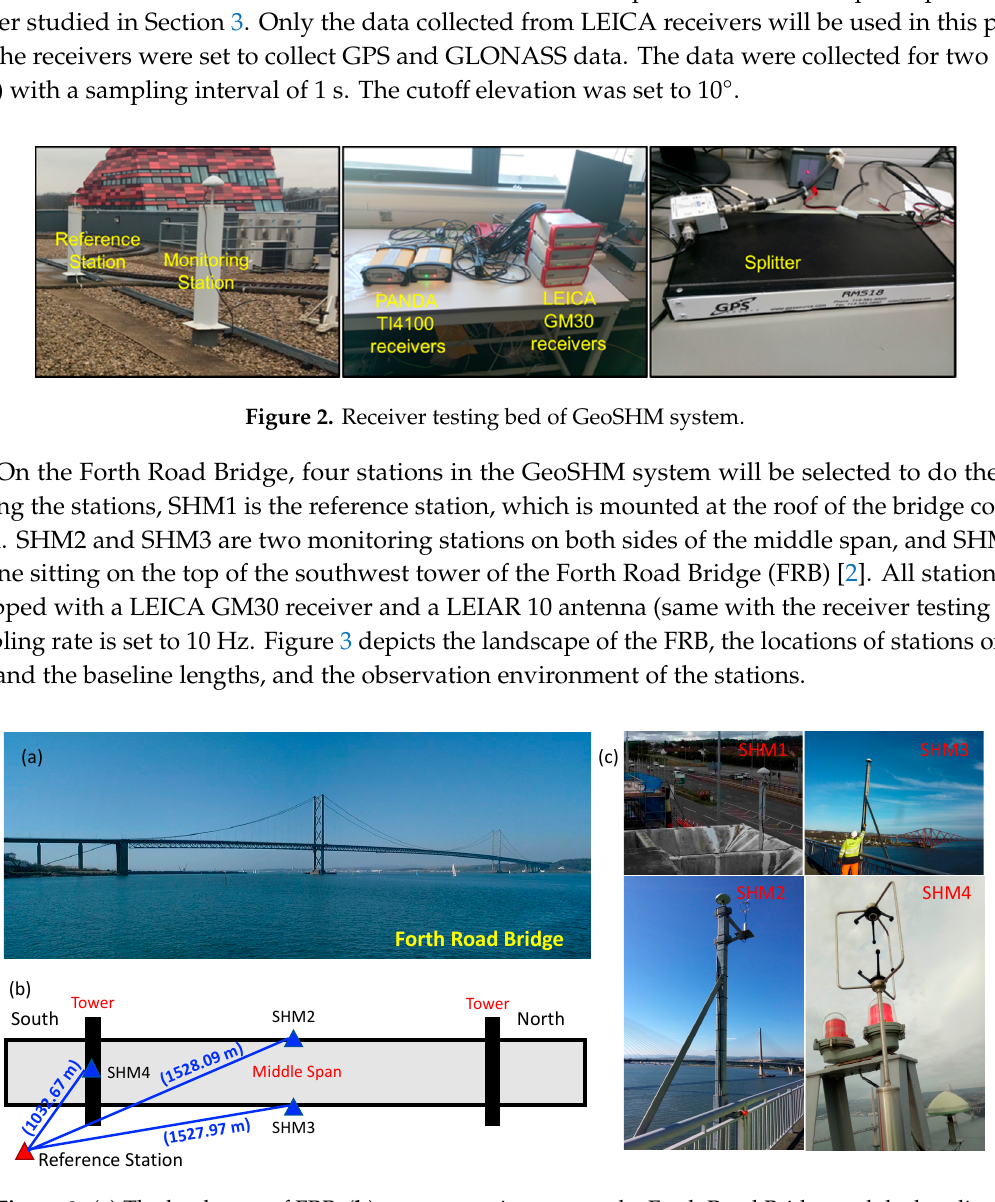
Figure 3. ( a ) The landscape of FRB, ( b ) antenna setting-ups on the Forth Road Bridge and the baseline lengths and ( c ) the observation environment of the stations.